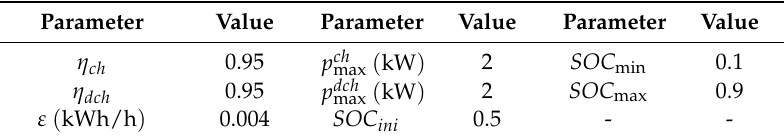
Table 3. Parameters of the energy storage